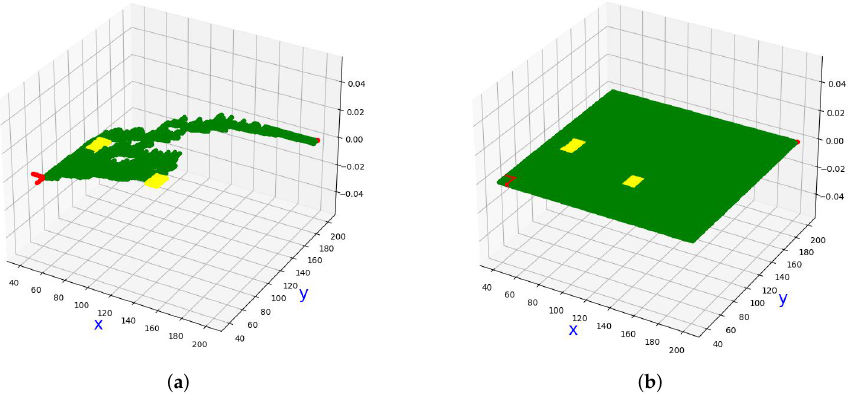
Figure 7. The search process of ( a ) the A* algorithm; ( b ) Dijkstra’s